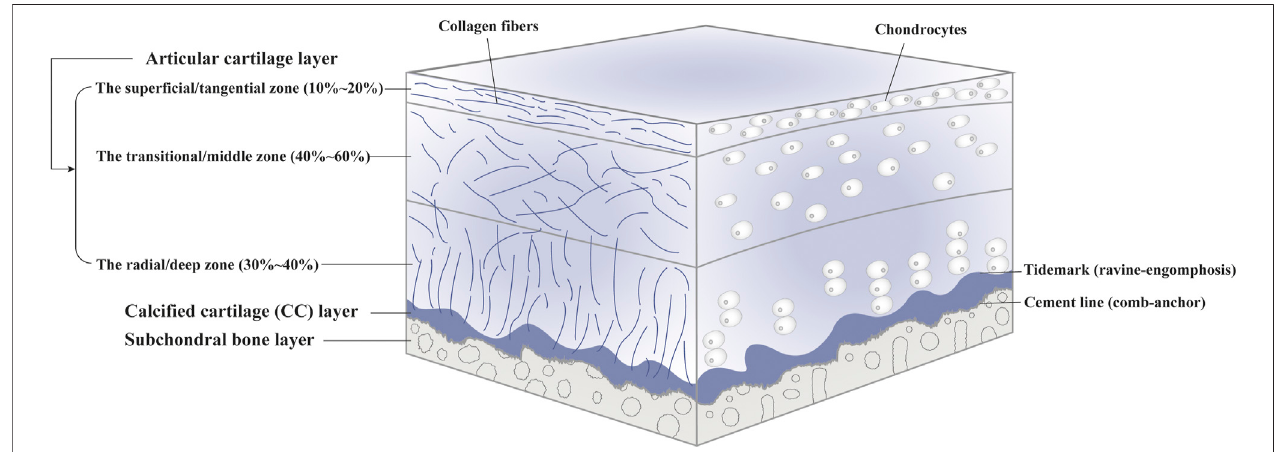
FIGURE 1 | The components of native osteochondral (OC)